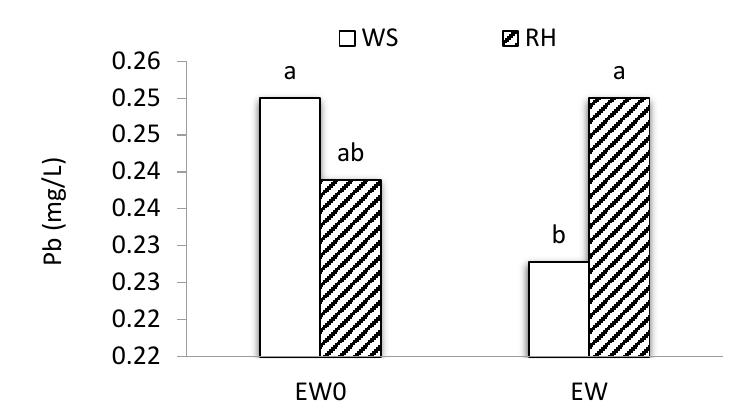
Figure 8. Effects of the treatments on the concentration of Pb in the wastewater EW0: without vermicomposting; EW: with vermicomposting; WS: wheat straw; RH: rice husk. Means in the same column followed by the same letter are not significantly different according to DMRT at (P≤0.05). Figure 8- Effects of the Treatments on the Concentration of Pb in the Wastewater